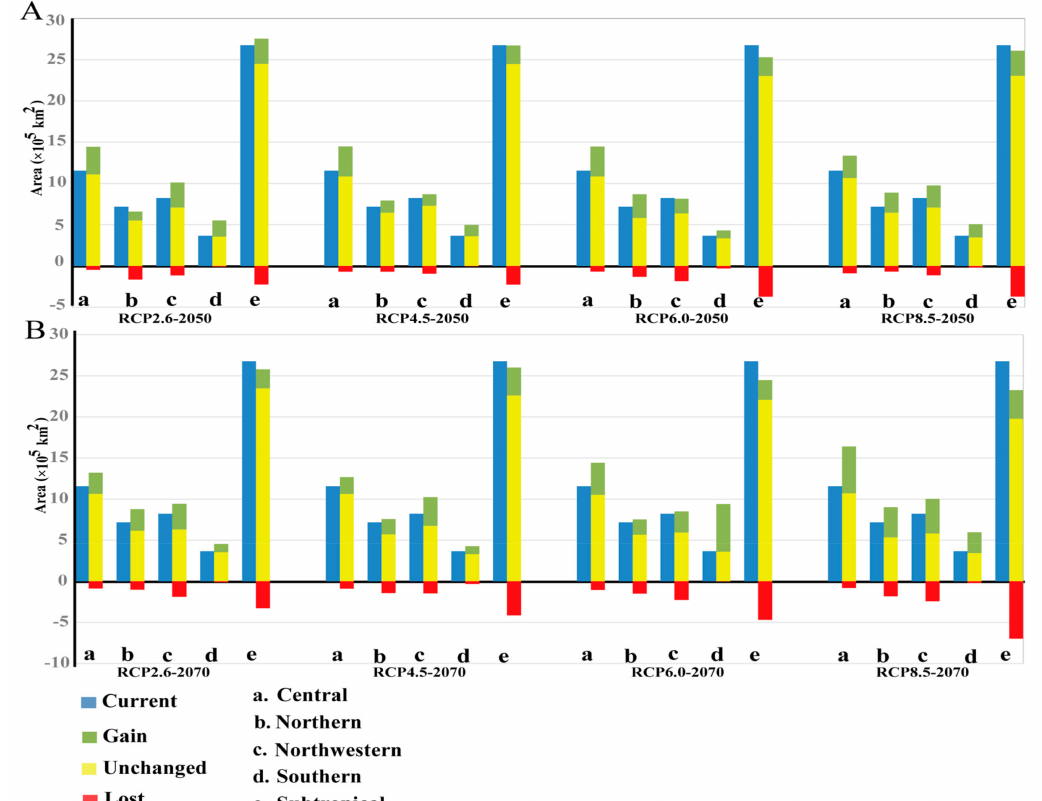
Figure 4. Areal changes in the projected distributions for the five seed zones under the eight future climate scenarios for 2050 ( A ) and 2070 ( B